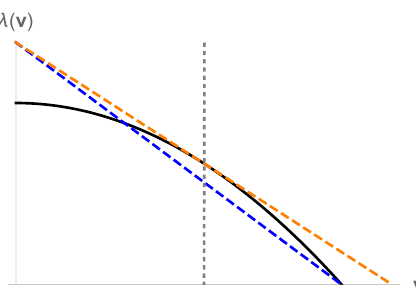
Figure 6 . The black curve is a typical saddle point contribution to the VDLE. If it was the dominant contribution to the VDLE for all v , it would violate the bound (1.8) drawn in dashed blue. To obey the bound (1.8), we need to increase the butter(cid:13)y velocity until the bound touches the black curve (this is the orange dashed line). The critical velocity v is where the two curves (cid:3) touch (gray, dotted), and for v > v , the saddle cannot (cid:3)